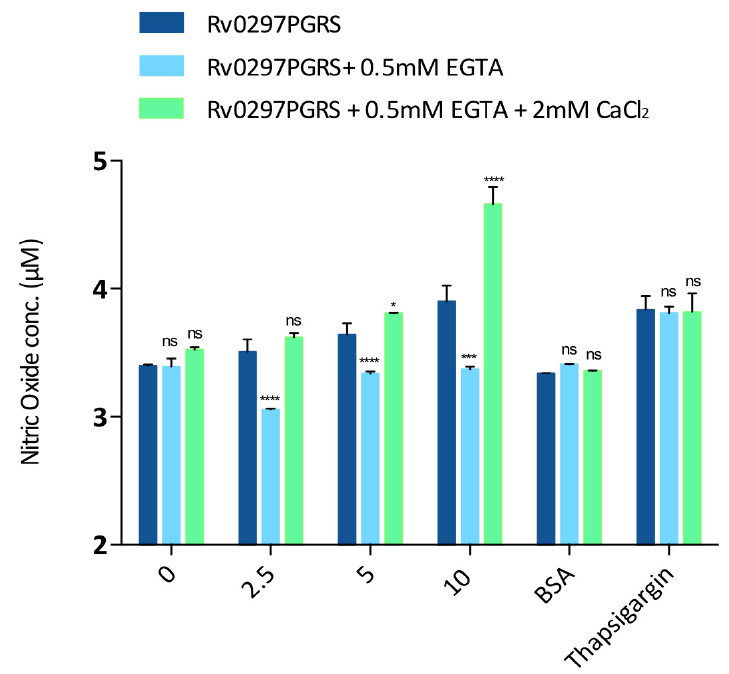
Figure 6. Rv0297 PGRS enhances the production of NO from macrophages in the presence of calcium ions. Assessment of NO production from Rv0297 PGRS stimulated RAW264.7 cells in the presence and absence and absence of Ca 2+ ions was performed. Calcium’s presence was observed to enhance Rv0297 PGRS induced NO secretion from treated macrophages. In comparison to that, the removal of Ca 2+ leads to reduced production of NO in response to rRv0297PGRS protein. One micromolar thapsigargin was used as positive control. BSA (10 µ g/mL) was used as negative control. Data were plotted in NO concentration. All values were represented as means ± SDs from three independent experiments. p values for *, ***, ****, and ns are <0.05, <0.01, <0.001, and >0.05,